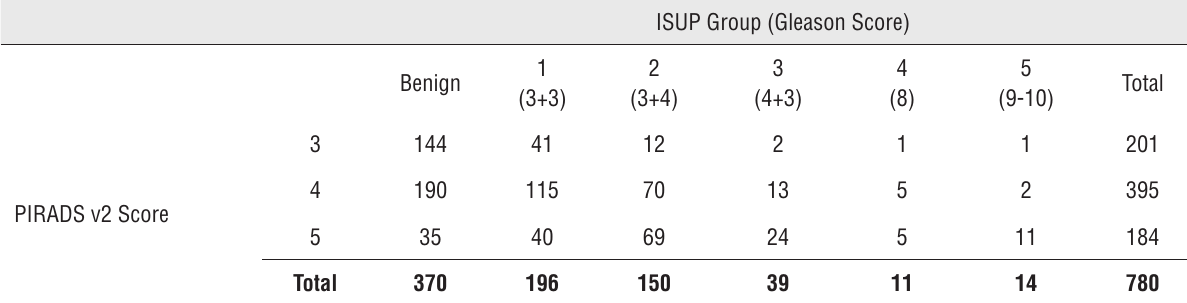
Table 2 - Biopsy results by PI-RADS v2 scores.